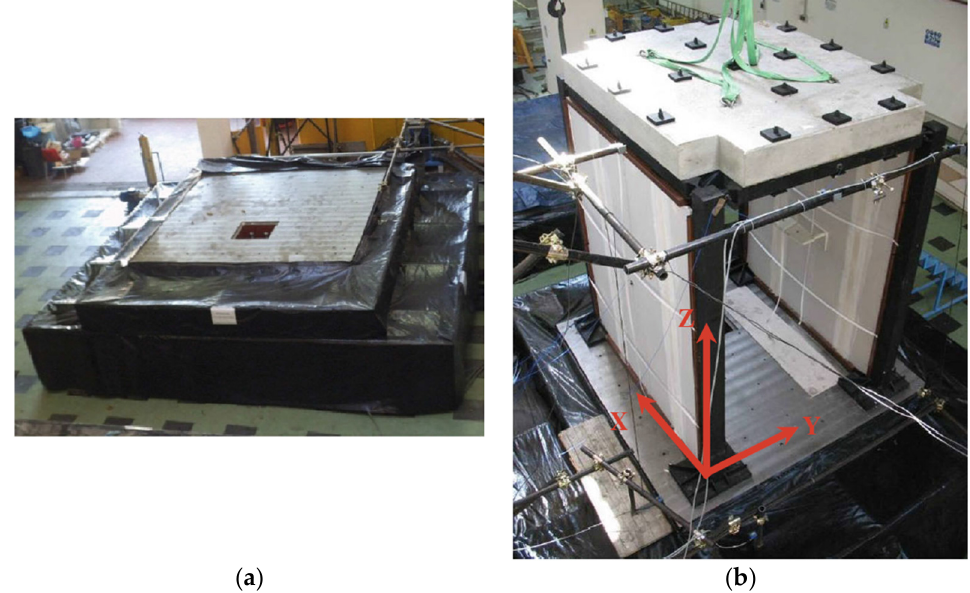
Figure 18. Test setup for multi-floor dynamic testing according to Magliulo et al.: ( a ) shake table test and ( b ) test frame [44].